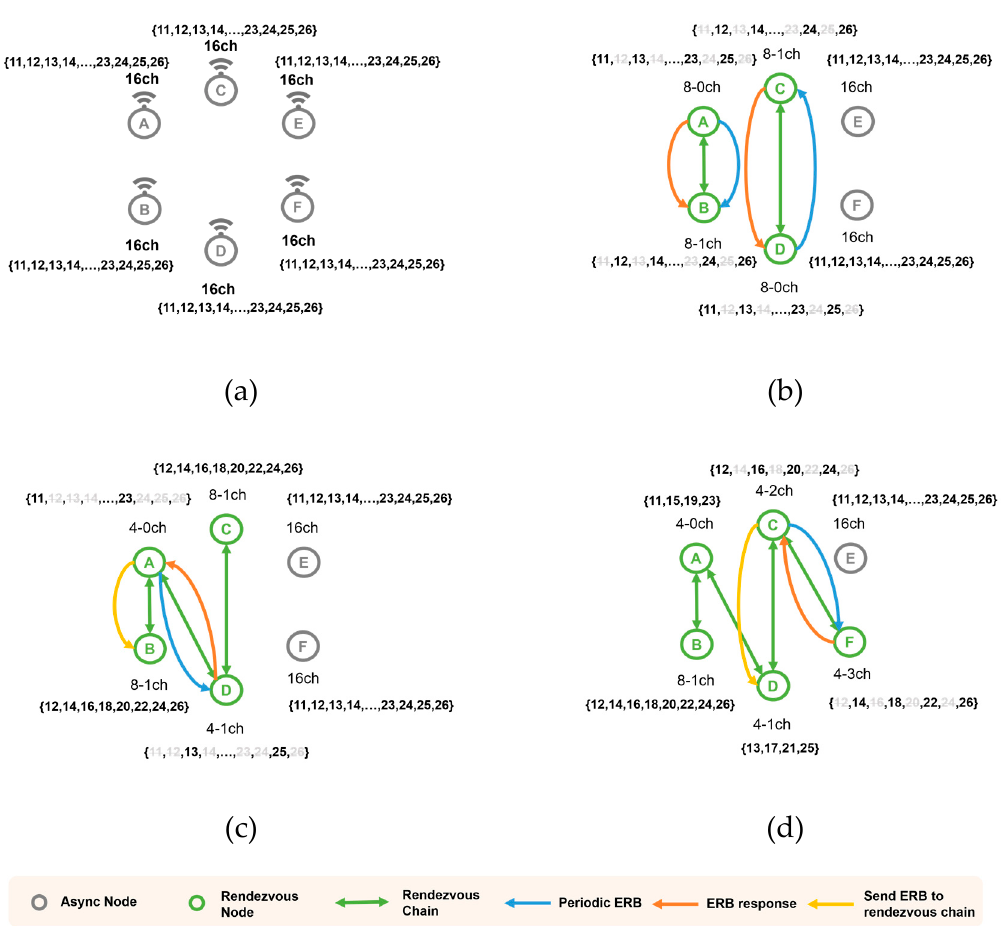
Figure 6. DRL-TSCH Operation Example ( a ) All nodes listen to 16 channels ( b ) A, B and C, D form rendezvous chain ( c ) A and D form the rendezvous chain ( d ) C and F form the rendezvous chain.